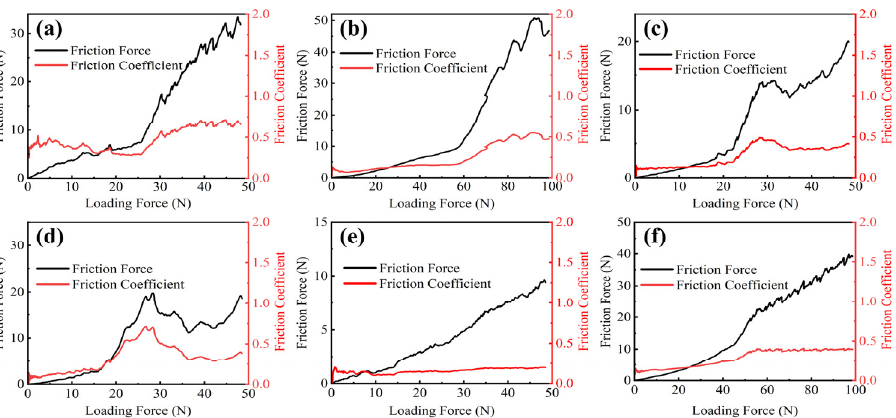
Figure 9. The friction coefficient and friction force curves with the loading force in scratch tests for ( a ) TiCrN, ( b ) TM0, ( c ) TM1, ( d ) TM2, ( e ) TM3, and ( f ) TM4 coatings.